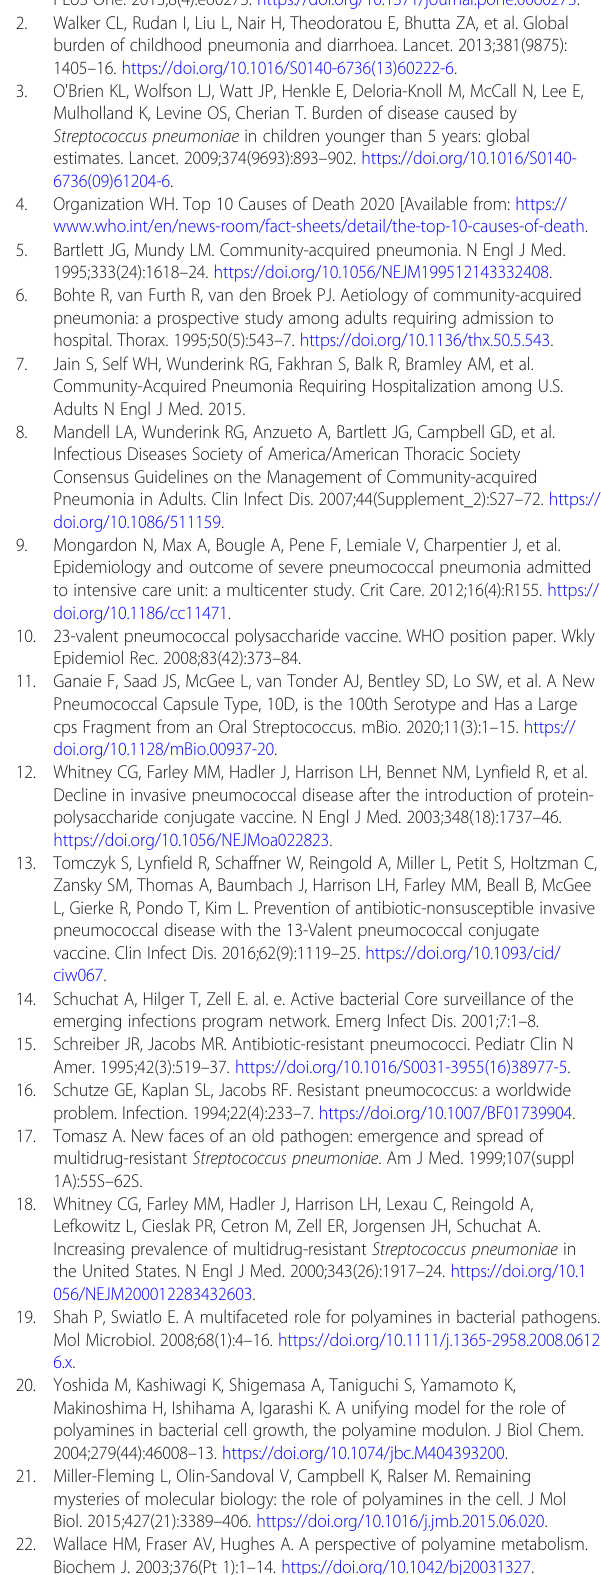
Table 2 Functions of polyamines in Streptococcus pneumoniae